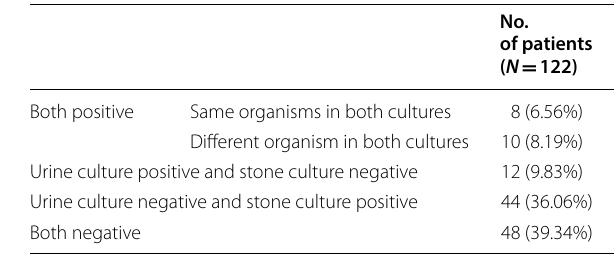
Table 3 Bacteriological analysis of stones and No. of patients